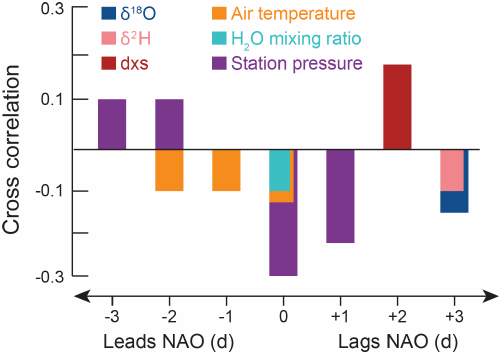
Figure 4. Cross-correlation analysis results between the NAO index and selected isotopic and meteorological variables. Results shown are all statistically significant at p < 0 . 05 ( n = 737), and nonsignif- icant results are not